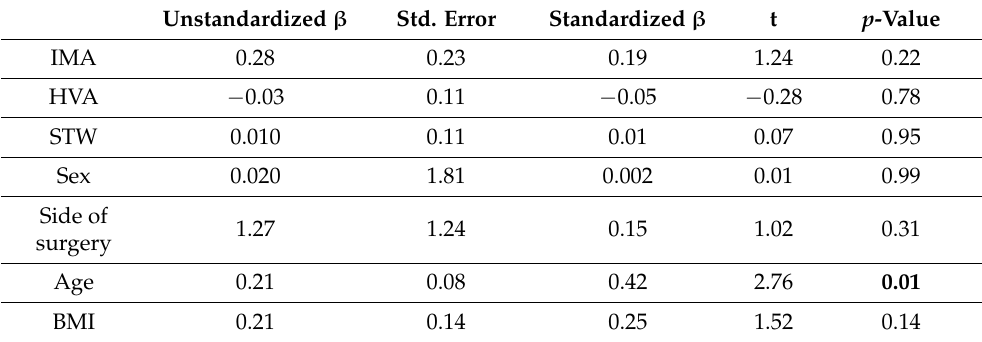
Table 4. Multivariate analysis of BW change by IMA, HVA, STW, sex, side of surgery, age, and BMI. Unstandardized β Std. Error Standardized β